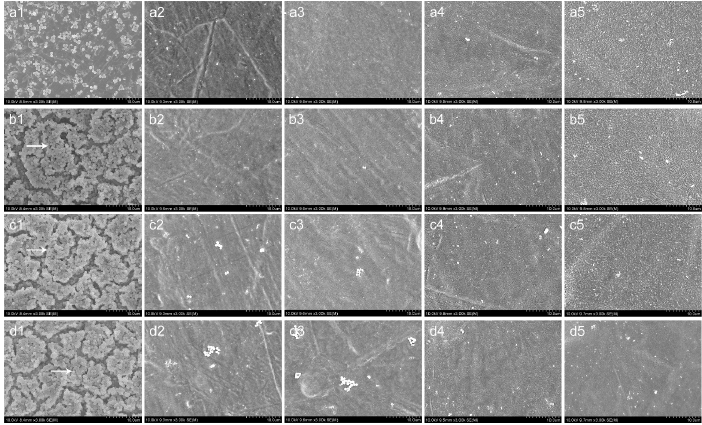
Figure 5. SEM images of ATCC 43300 adhesion and biofilm formation on different surfaces. (1) Smooth Ti; (2) NT-H80; (3) NT-H120; (4) NT-H160; (5) NT-H200 after ( a ) 6 h; ( b ) 24 h; ( c ) 48 h; and ( d ) 72 h incubation. Arrow head indicates the bacteria colony in biofilm. The magnification level is ˆ 3000. The scale bar is 10 µ